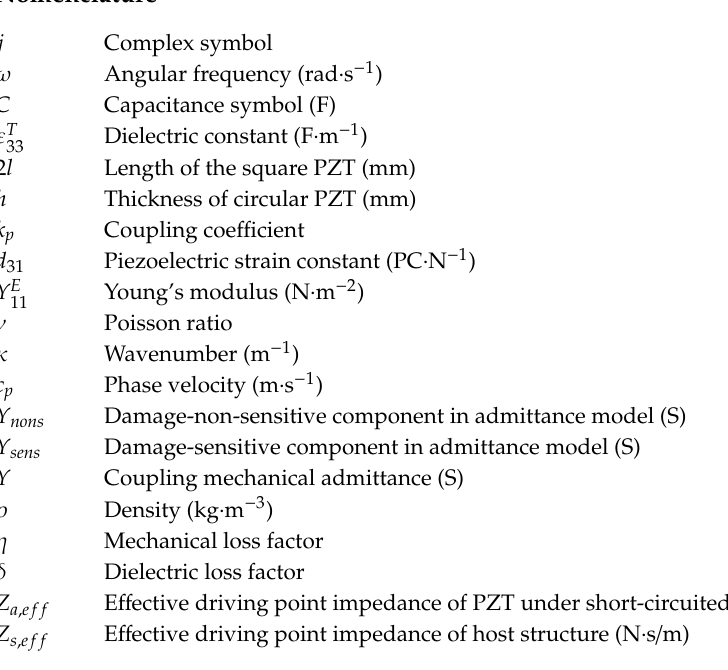
E ff ective driving point impedance of host structure (N · s /